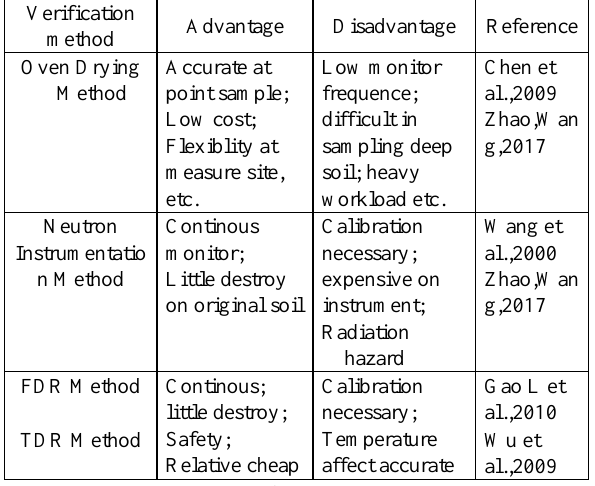
Table 1. Comparison of point scale measure method